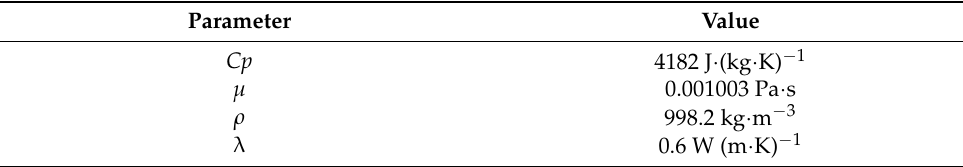
Table 1. Physical parameters of